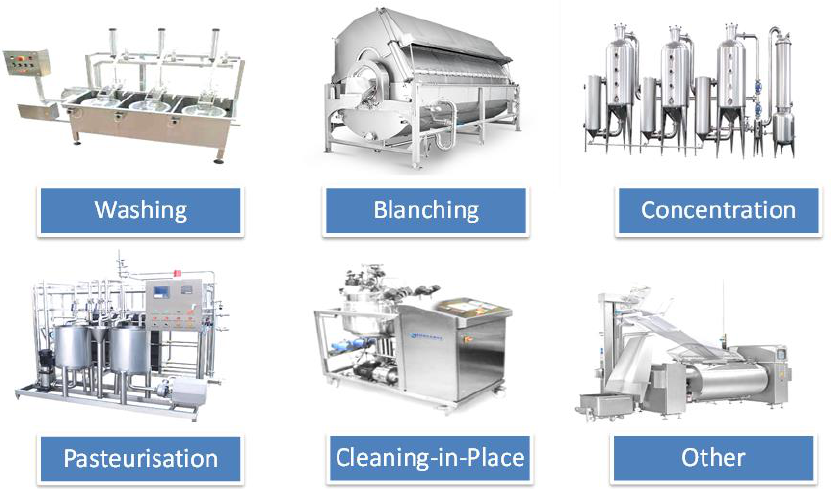
Figure 3. Examples of unit operations in a food factory with substantial heating demands [21]. Reproduced with the permission of the International Institute of Refrigeration (IIR).